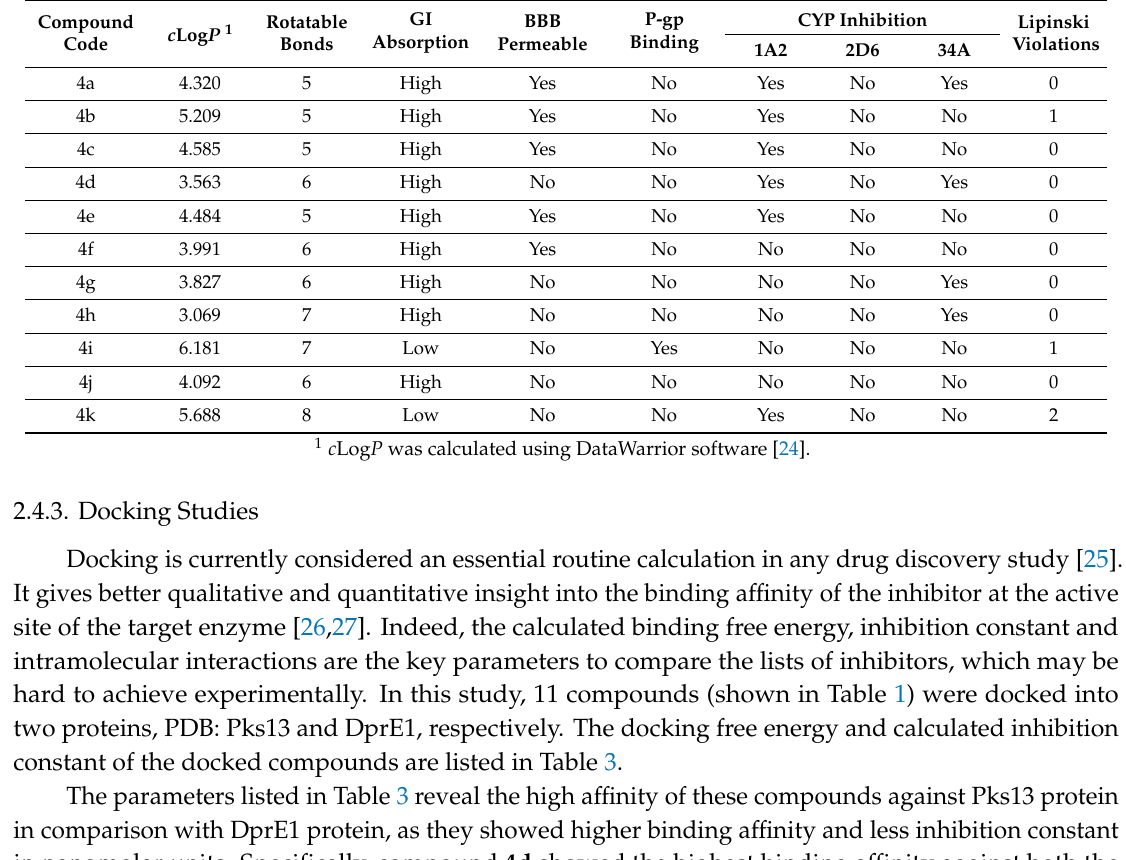
Table 2. Result of absorption, distribution, metabolism, and excretion (ADME) prediction from SwissADME web server. GI, gastrointestinal; BBB, blood–brain barrier; CYP, cytochrome P. Compound